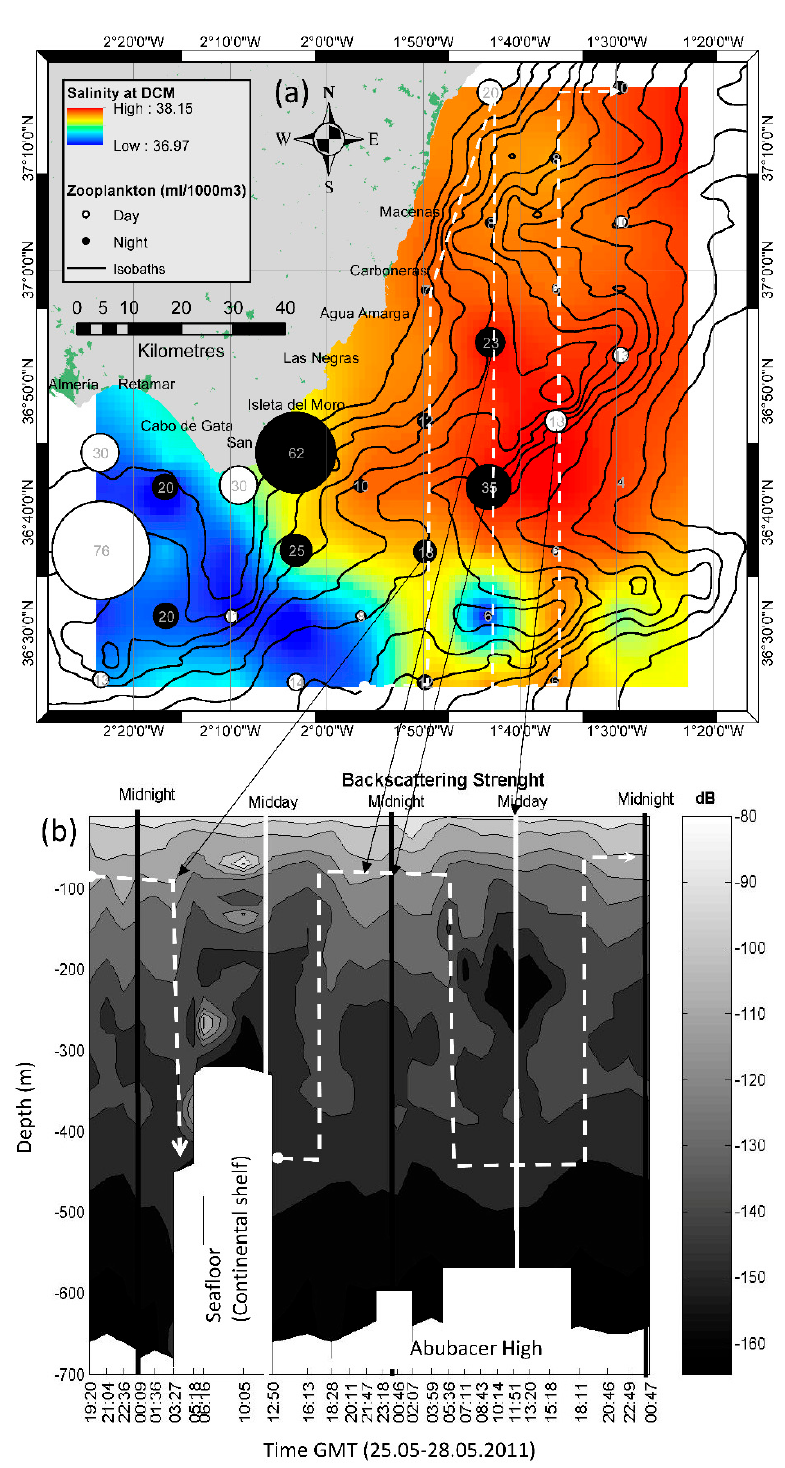
Figure 8. ( a ) Spatial distribution of zooplankton biovolume concentration (mL per 1000 m 3 ) in the first 100 m of the water column. The white dotted line indicates the transect of the vertical backscatter transect shown in ( b ). ( b ) The vertical backscatter signal between Stn 55 and 90 indicates the daily vertical migration (DVM) of zooplankton. Stronger (less negative) backscatter (dB) indicates higher plankton concentration [52]. The white dotted line schematically indicates the zooplankton migration behavior along the backscatter transect shown in Figure 8a.